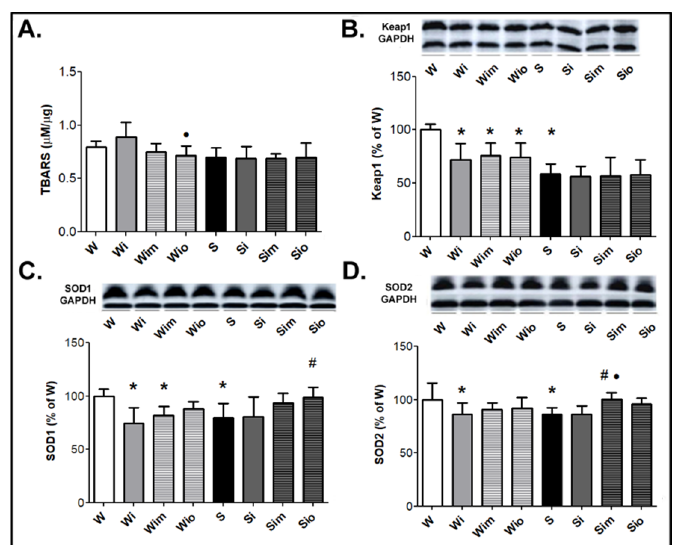
Figure 10. Demonstration of examined myocardial markers modulating redox state, TBARS ( A ), Keap1 ( B ), SOD1 ( C ), and SOD2 ( D ) in experimental rats. There were no changes in TBARS among the groups. The protein level of Keap1 was lower in the spontaneously hypertensive rat (S) compared to Wistar rat (W) hearts and reduced in response to ISO in W rats (Wi) while not in S (Si). Treatment with melatonin and omega-3 did not affect this parameter regardless of the strain (Wim, Wio, Sim, Sio). Protein levels of SOD1 and SOD2 were lower in S compared to W rat hearts. ISO exposure resulted in suppression of SOD isoforms in Wistar rats (Wi) but not in S (Si). There was a tendency to increase SOD1 and SOD2 in both ISO-exposed rat strains by treatment either with melatonin or omega-3. Values are the mean ± SD of 10 rats in each group. * p < 0.05 compared with W; # p < 0.05 compared with S; • p < 0.05 compared to Wi vs. Wim, Wio / Si vs. Sim,